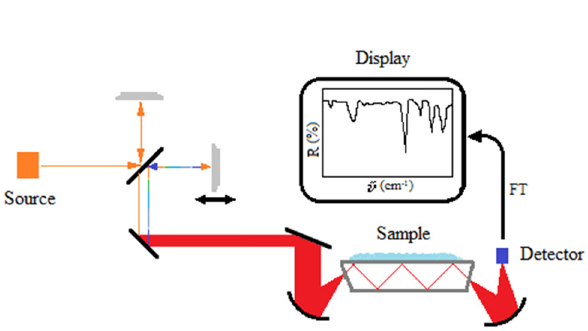
Figure 1: Schematic diagram of ATR - FTIR